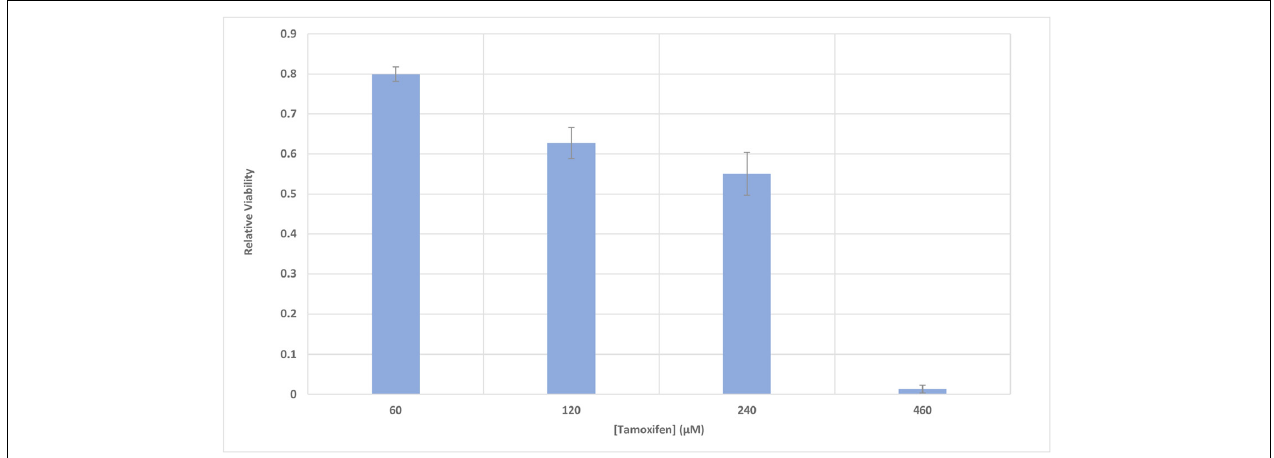
FIGURE 4 | The relative viability of MCF-7 cells incubated with various concentrations of tamoxifen. The viability of the treated cells is shown to be different from the control in the presence of different concentrations of tamoxifen (60–460 µ M). The incubation time of the treatments was 48 h. It can be seen that 50% decrease in the viability of the cells can be achieved approximately with 250 µ M of tamoxifen and this is utilized in conjunction with all treatments here for induction of apoptosis in the cells.